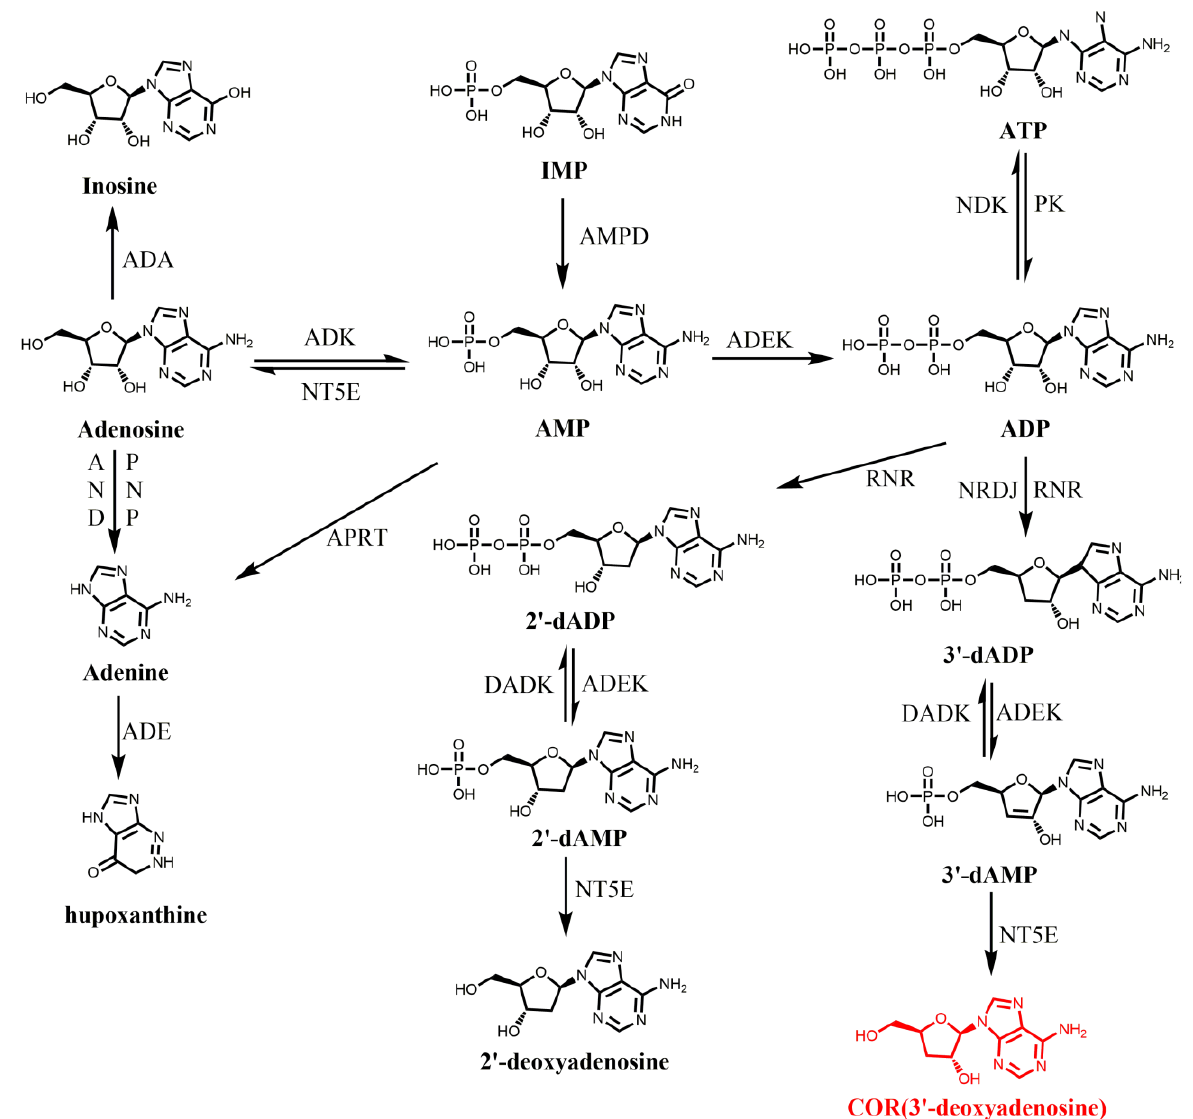
Figure 1. The adenosine metabolism pathway and possible COR biosynthesis pathway [60–62]. Abbreviations: IMP: inosine monophosphate; AMP: adenosine monophosphate; ADA, adenosine deaminase; ADE, adenine deaminase; ADK: adenosine kinase; ADEK, adenylate kinase; ADN, adenosine nucleosidase; ADK, adenosine kinase; DADK, deoxyadenylate kinase; NDK, nucleoside-diphosphate kinase; AMPD, AMP deaminase; dAMP: deoxyadenosine monophosphate; ADP: adenosine diphosphate; dADP: deoxyadenosine diphosphate; RNR: ribonucleotide reductases; APRT, adenine phosphoribosyltransferase; NT5E , 5′ -nucleotidase; PNP, purine nucleoside phosphorylase; RNR, ribonucleotide triphosphate reductase.